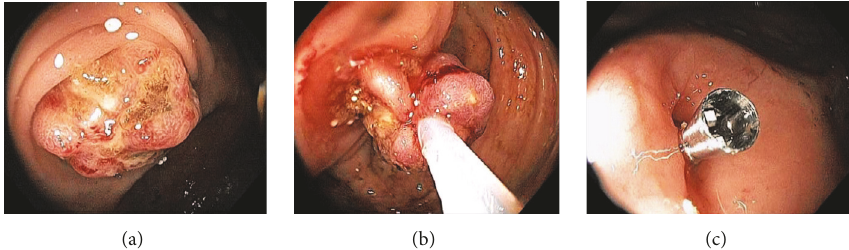
Figure 38: Endoscopic image of a 12 mm appendiceal adenoma with high-grade dysplastic features (a). On gentle manipulation of the ensnared lesion, the polyp is found to be pedunculated (b). In order to position the snare at the polyp stalk, the endoscopic catheter is gently advanced into the orifice before closing the snare. In order to achieve hemostasis for mild oozing, a semiopened endoclip is advanced into the orifice and applied at the base (c). On pathological examination of the resected polyp, there was focal high-grade dysplasia but the resection was considered curative.